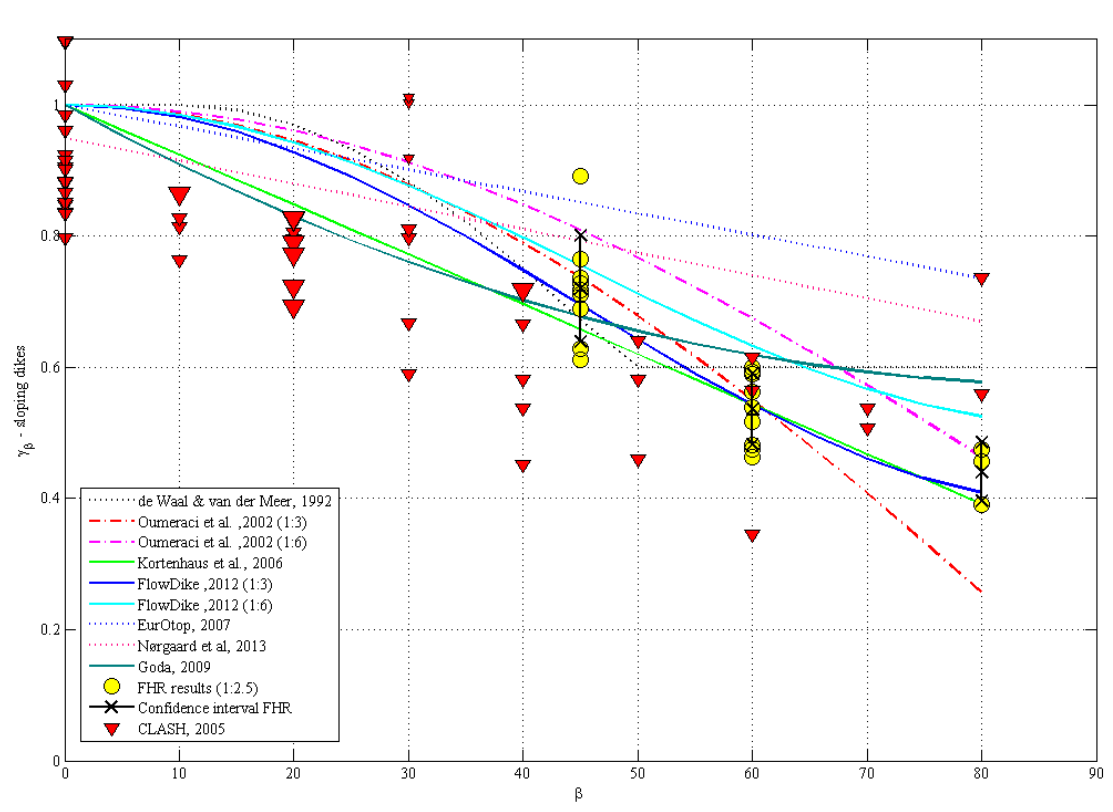
Figure 14. Sloping dike: variation of reduction coefficient with wave angle; comparison with existing formulas.